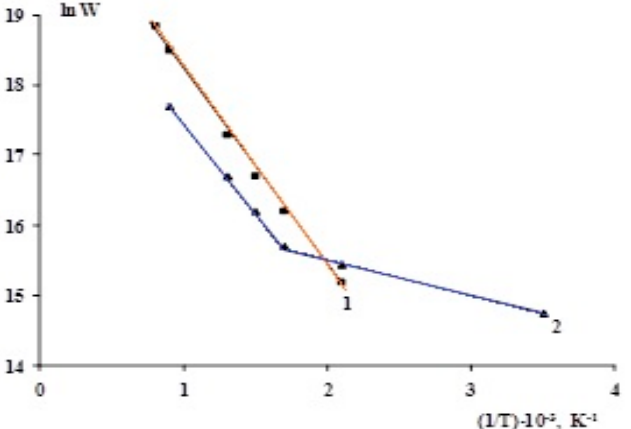
Figure 4. Temperature dependences of molecular hydrogen production during thermal ( 1 ) and radiation–thermal ( 2 ) processes in the Zr1%Nb + seawater system.